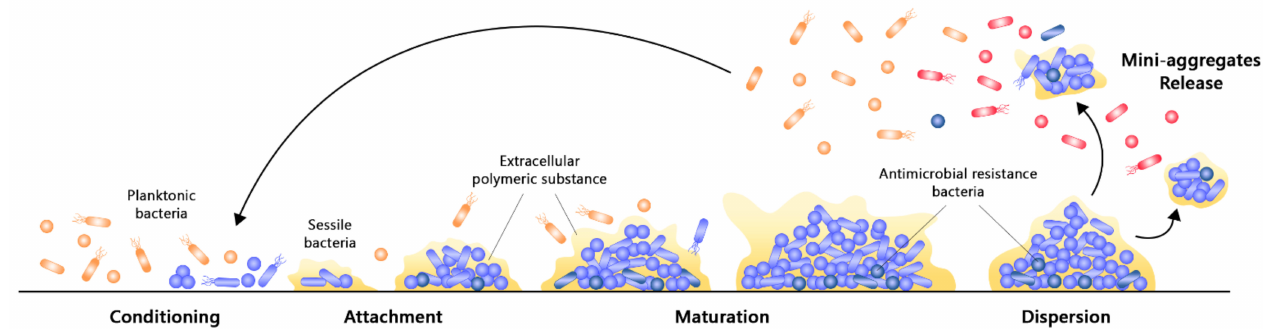
Figure 2. Schematic representation of the different stages in biofilm formation. The process begins with a reversible attachment of planktonic bacterial cells and their adhesion to the surface. Once they form a monolayer, the bacterial cells become irreversibly attached and the production of extracellular polymeric substance will be initiated. As the biofilm matures, microcolonies are formed where bacterial cells aggregate and accumulate in multiple layers. Finally, the mature biofilm disperses and releases planktonic bacterial cells, starting a new cycle of biofilm